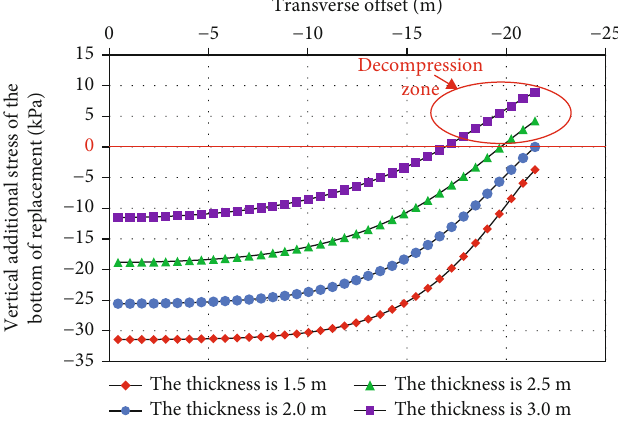
Figure 13: The transverse distribution of vertical additional stress on the bottom of